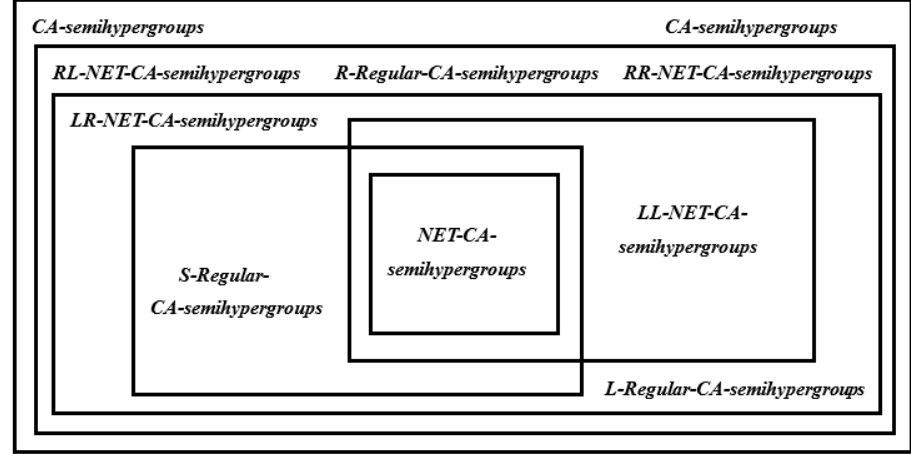
Figure 13. The relationships among various Net-CA-semihypergroups.